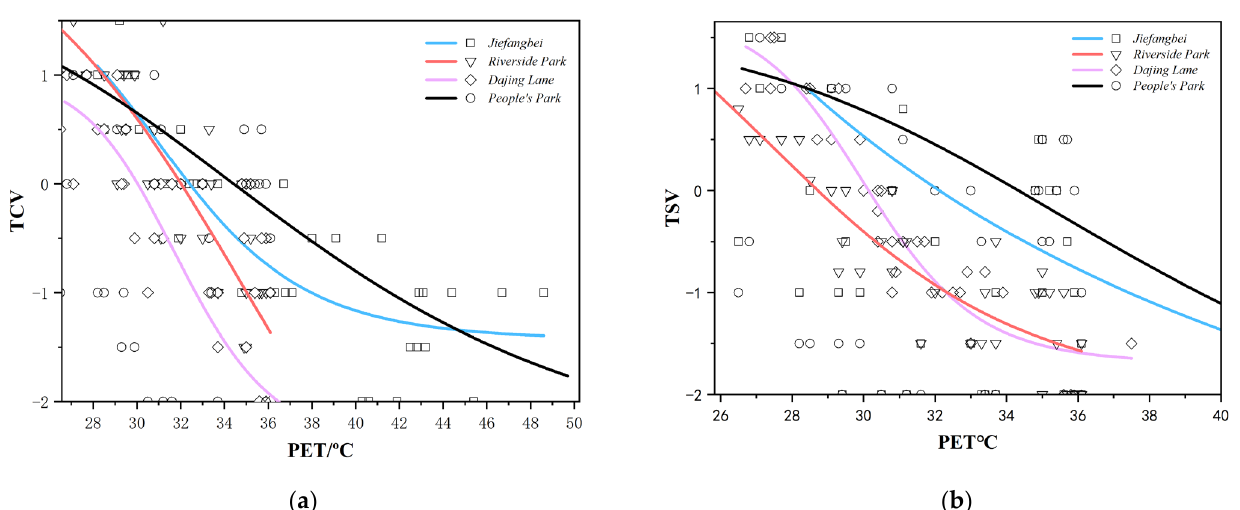
Figure 8. Nonlinear fitting of crowd heat voting to PET: ( a ) Relationship between TCV and PET for thermal comfort voting in each measurement area; ( b ) Relationship between TSV and PET for thermal sensory voting in each measurement area.